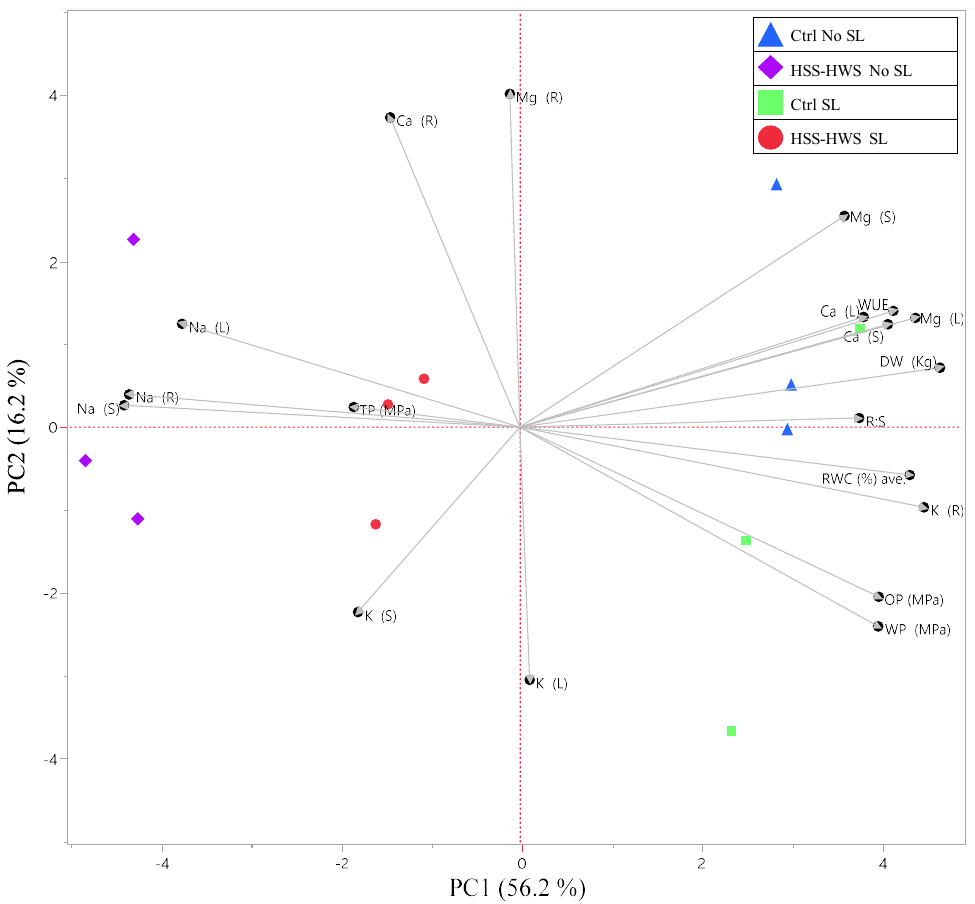
Figure 5. Biplot of the principal component analysis of biomass, morphological and leaf water status traits, and element translocation indices in the four treatments. The amount of variation associated with each PC is indicated in brackets. Ctrl, control; HSS-HWS, high soil salinity and high water salinity; SL, salt leaching; Na(R), Na(S), and Na(L), Na concentration in roots, stem, and leaves, respectively; K, Ca, and Mg followed by (R), (S), and (L) indicates K, Ca, and Mg concentrations in the respective organs; DW, plant dry weight; R:S, root to shoot ratio; RWC, relative water content; WP, leaf water potential; OP, osmotic potential; TP, turgor potential.